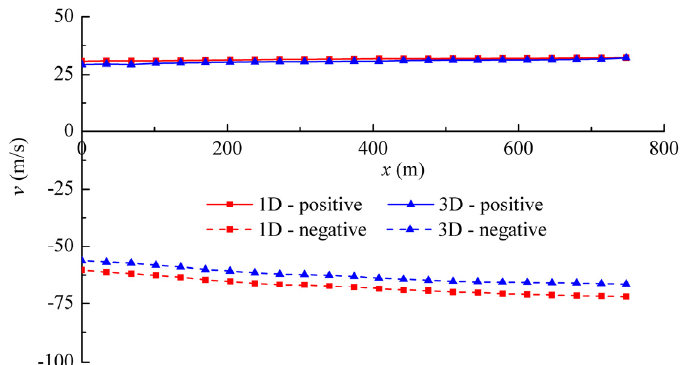
Figure 7. The comparison of the positive and negative (extremum) envelope curves along the axis of ventilation tunnel, simulated by 1D and 3D methods.